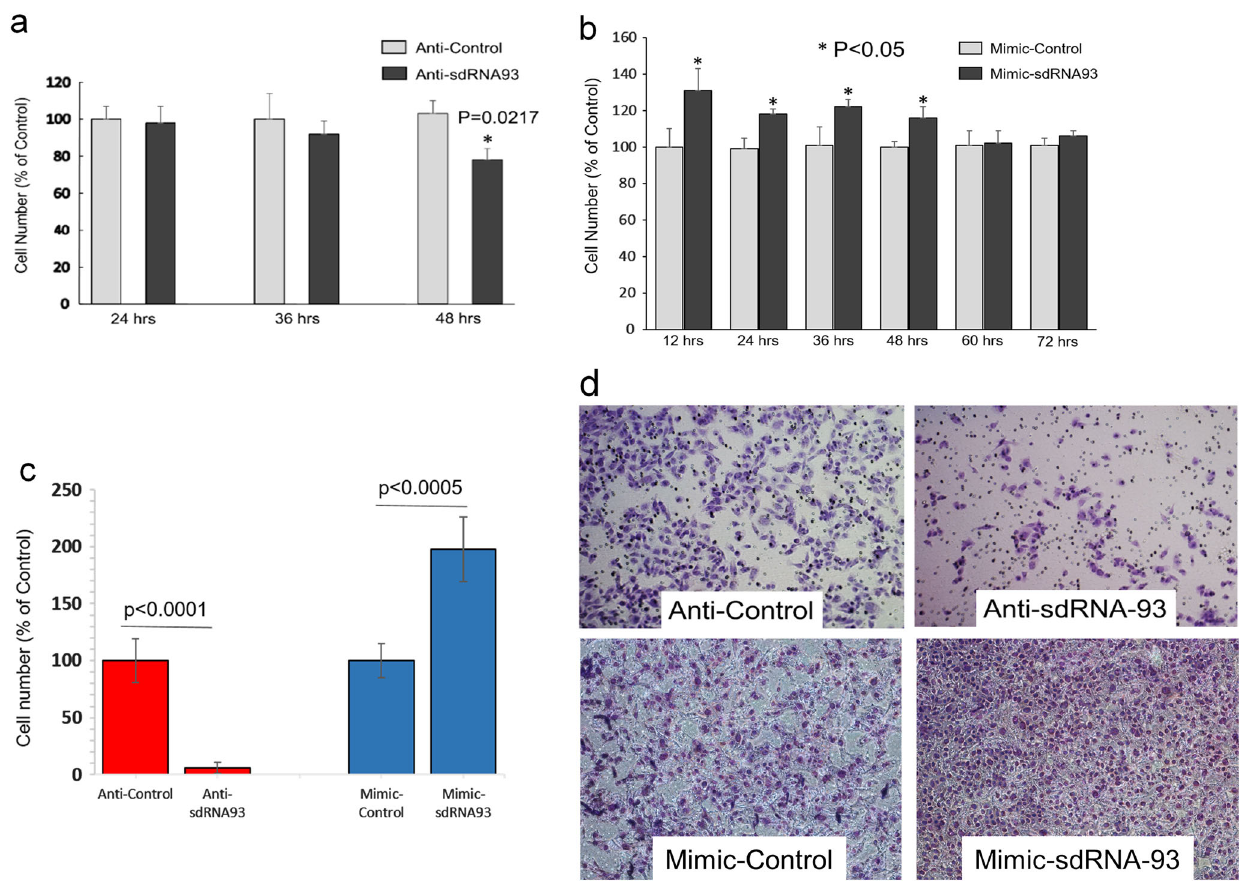
Fig. 3 Effects of altered sdRNA-93 expression on MDA-MB-231 cells. a MDA-MB-231 cell lines were transfected with anti-sdRNA-93 or a scrambled control RNA. Cell counts performed at 24, 36 and 48 h. b MDA-MB-231 cell lines were transfected with mimic-sdRNA-93 or a scrambled control RNA. Cell counts performed at 12, 24, 36, 48, 60 and 72 h. c Invasion assays were performed to evaluate the effect of manipulating sdRNA-93 levels on MDA-MB-231 cell invasion. Cell invasion was determined by embedded cell count at 48 h post transfection ( n ≥ 3). d Representative invasion assays quanti fi ed in